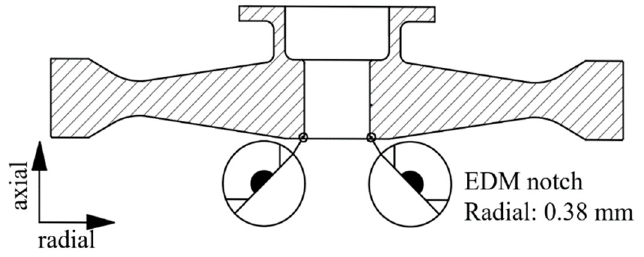
Figure 10. Initial flaws prefabricated by EDM.